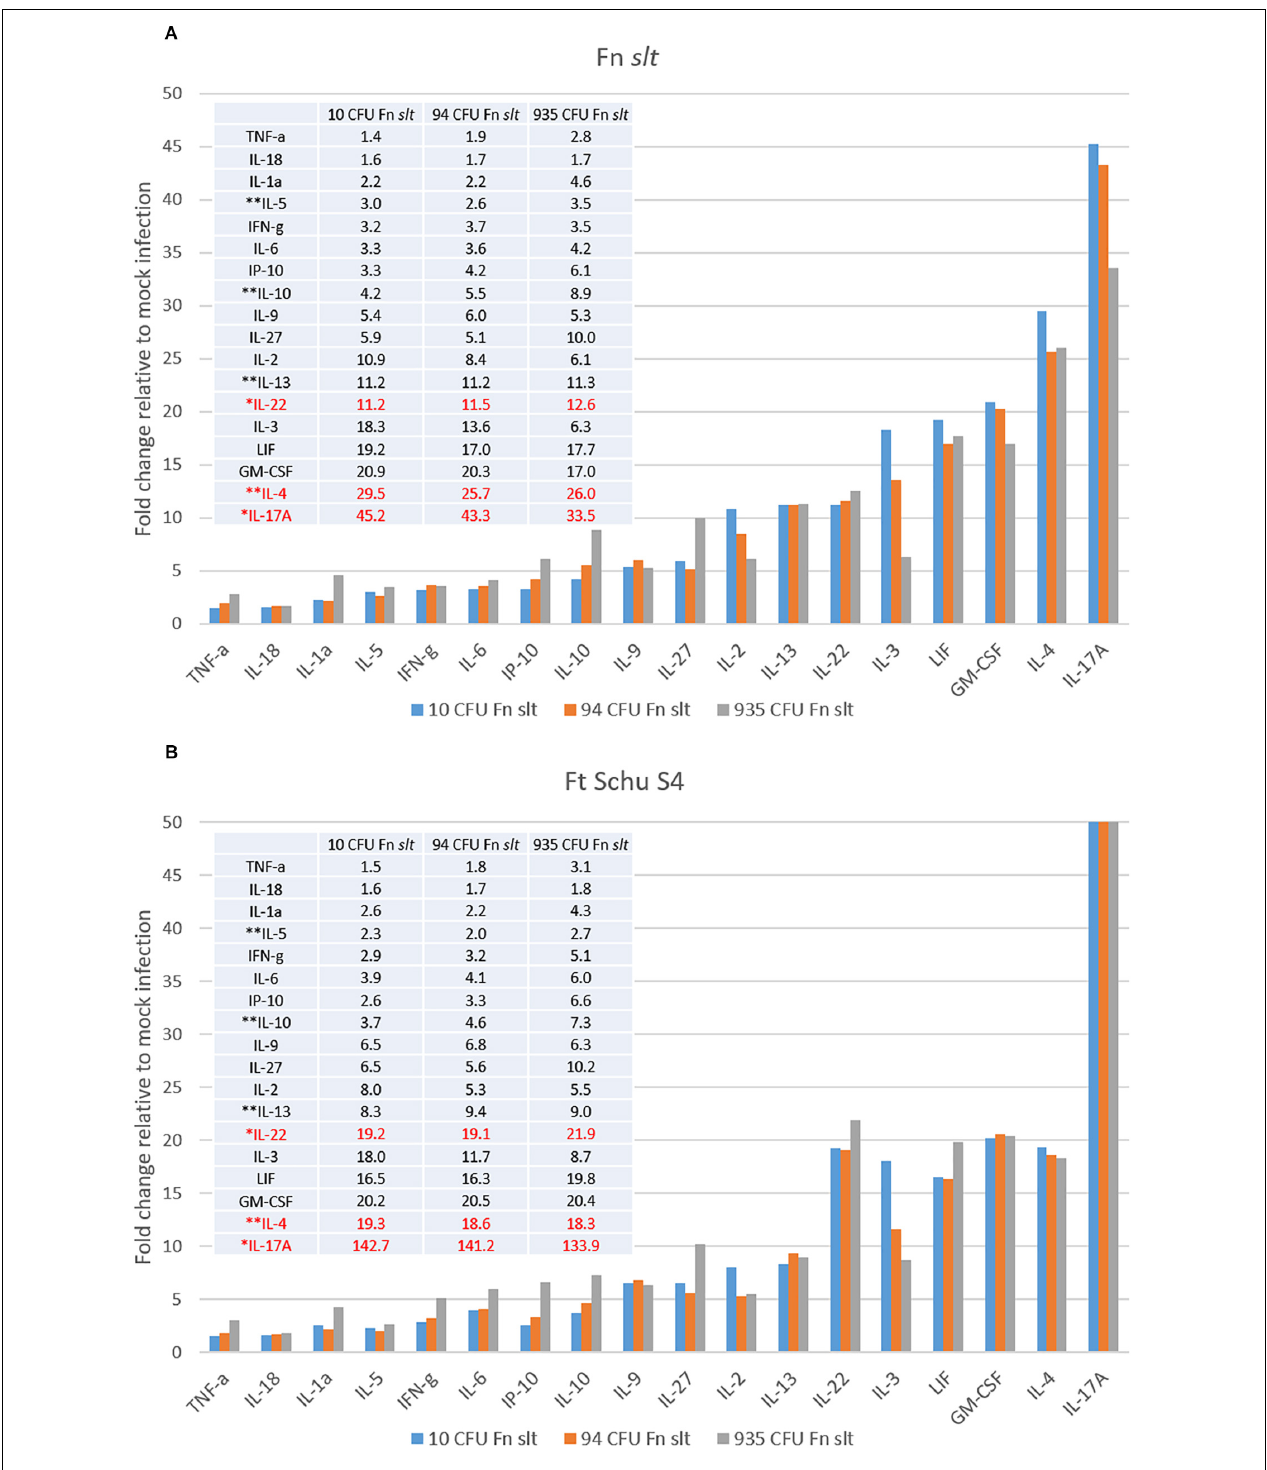
FIGURE 10 | Robust Th17- and Th2-type cytokine response in splenocytes re-stimulated with Fn slt or Ft Schu S4. BALB/c mice were infected intranasally with mock/PBS ( n = 5), 10 ( n = 5), 94 ( n = 5), and 935 ( n = 3) CFU Fn slt mutant. At day 21 post infection, mice were euthanized and spleens were harvested. Splenocytes (10 6 cells) were re-stimulated for 48 h in the presence of (A) irradiated Fn slt (5 µ g/ml) or (B) Ft Schu S4 (5 µ g/ml) and the levels of cytokines measured by the Luminex bead-based suspension assay. Graph and Table values are expressed as a fold change compared to PBS control group for each analyte. Red text indicates cytokine profiles which markedly differed between Fn slt and Ft Schu S4 re-stimulation. ∗ Th17-like cytokines; ∗∗ Th2-like cytokines. A P -value of < 0.05 was determined for every analyte by t -test of log10 values against PBS only controls.